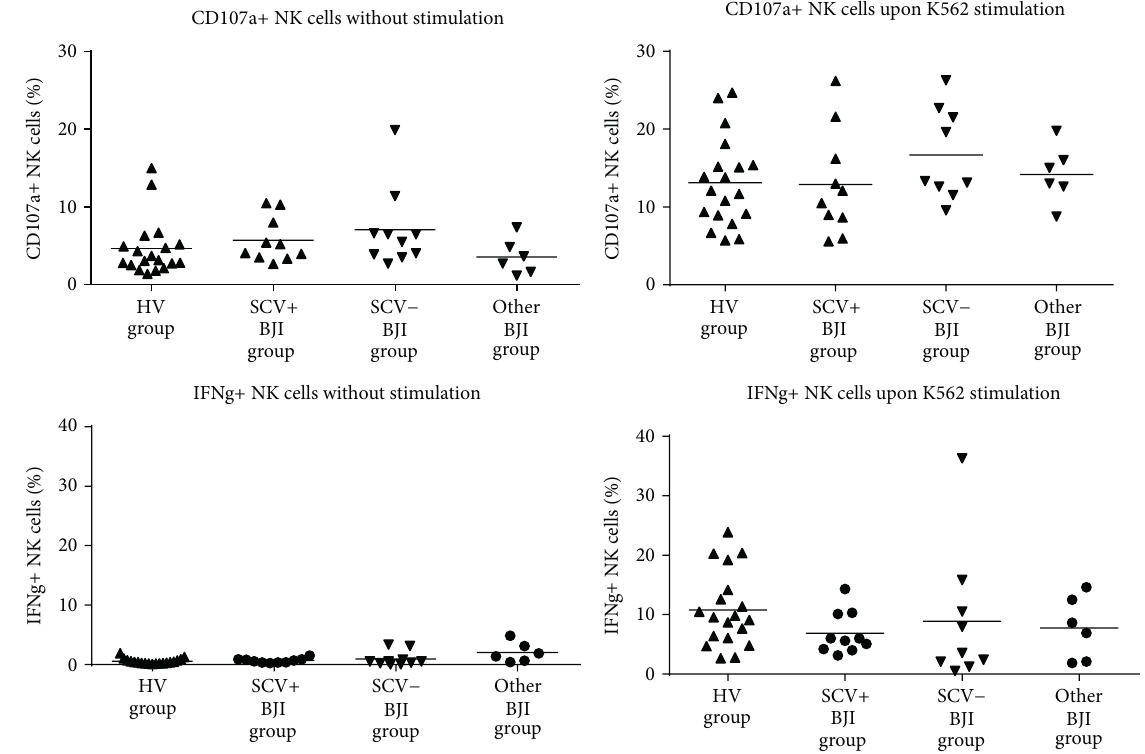
Figure 2: Degranulation and IFN- 𝛾 production by NK cells before and after stimulation with K562 cells.